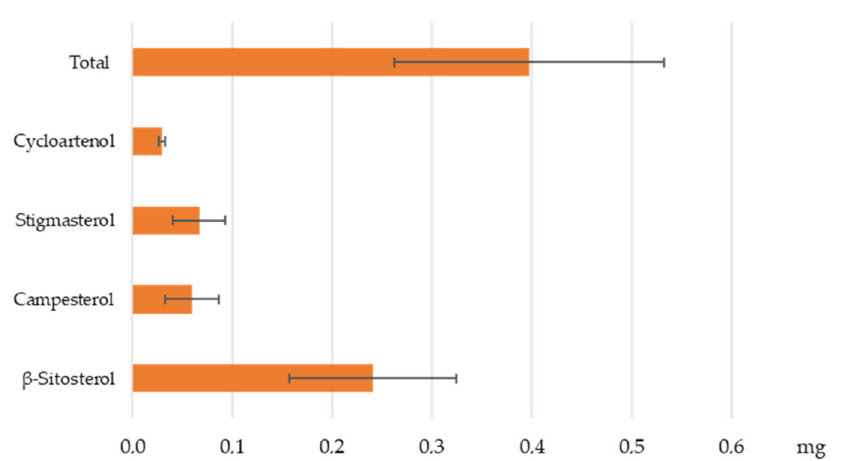
Figure 6. Mean levels of phytosterols (mg) in one cup of espresso coffee (25 mL). Results are expressed as mean ± standard deviation, with 14 biological replicates from 14 different samples ( n = 14).